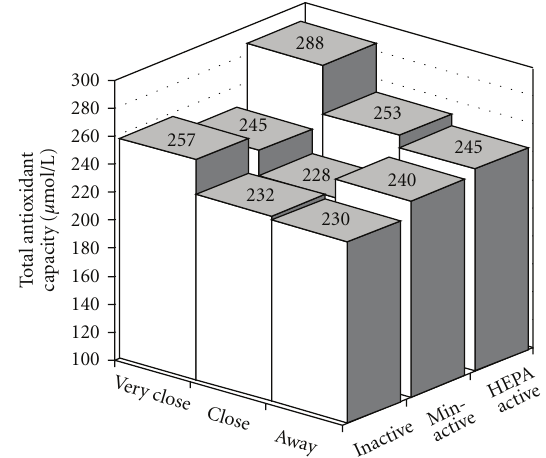
Figure 1: TAC levels and physical activity status (inactive, min- active, and HEPA active) by MedDietScore that assessed adherence to the Mediterranean diet (away, close, and very